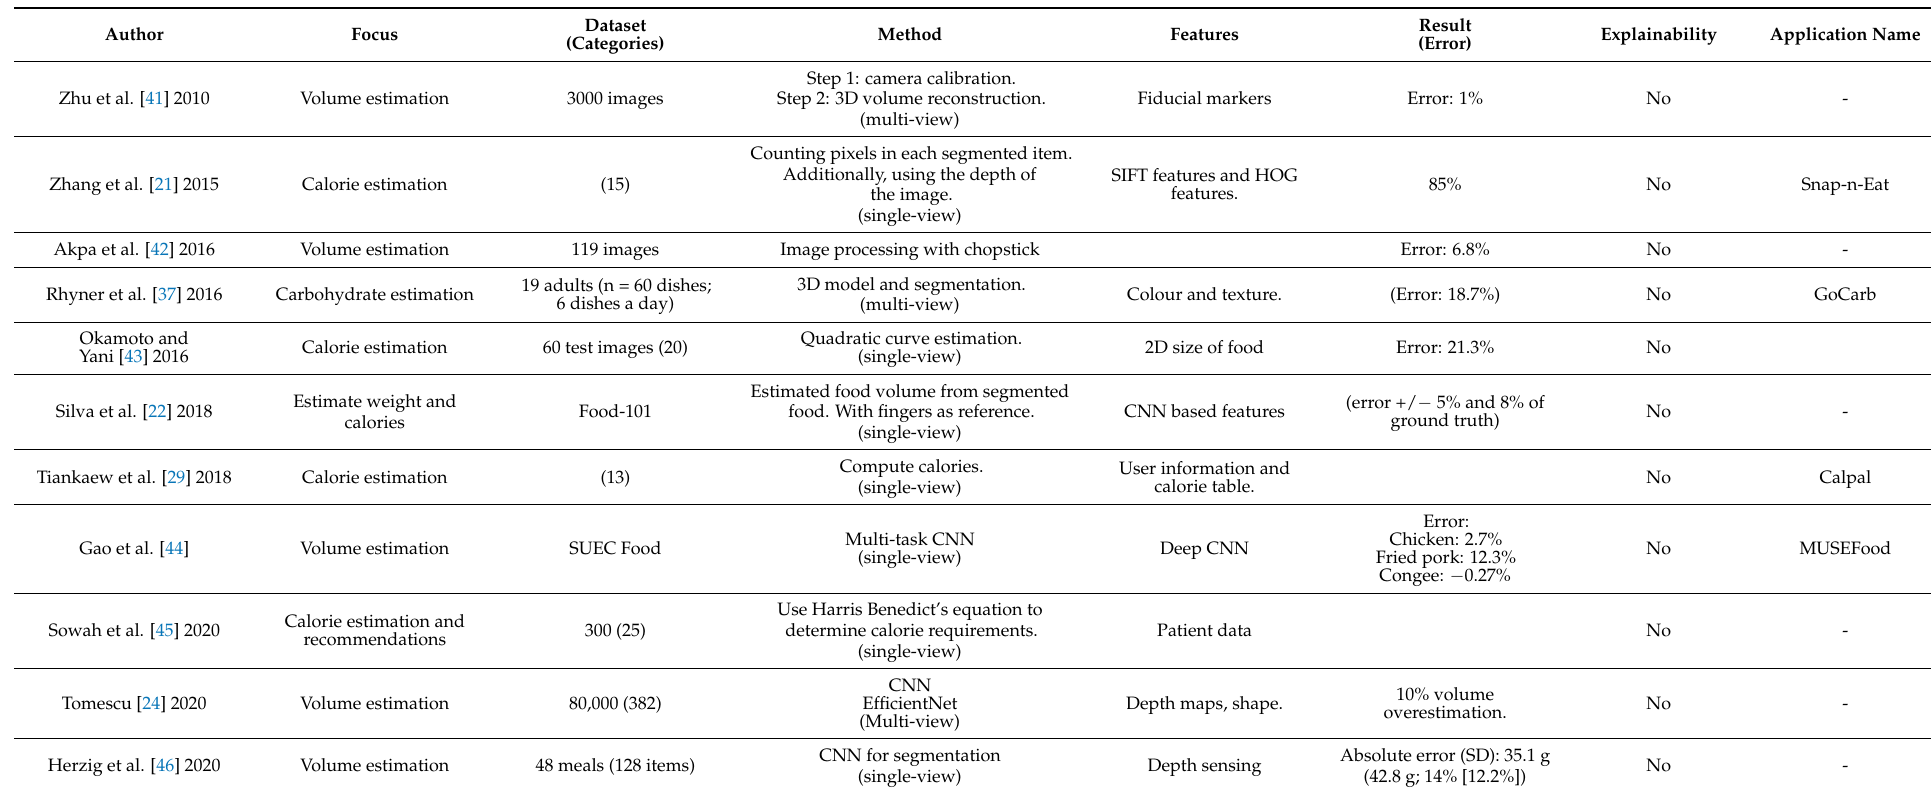
Table 4. Summary of food volume estimation methods used in mobile